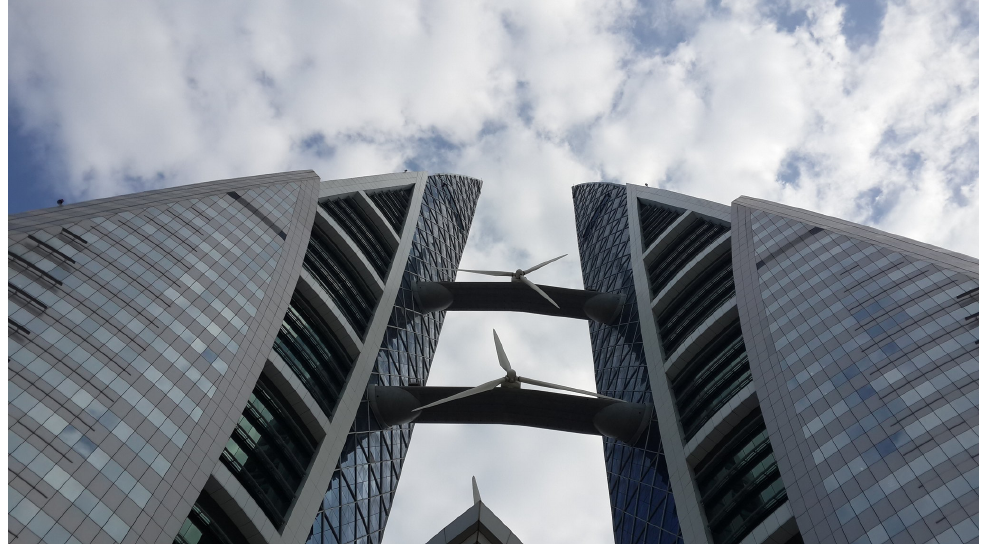
Figure 2. An array of three wind turbines is integrated between the two towers of the Bahrain World Trade Center (by Denise Krebs is licensed with CC BY 2.0. To view a copy of this license, visit https://creativecommons.org/licenses/by/2.0/ (accessed on 11 October